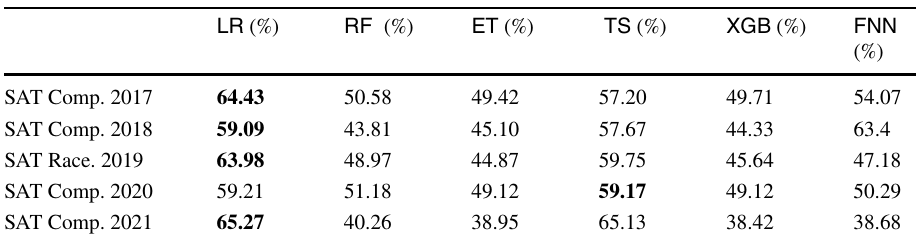
Table 5 Percentage of correctly classified real-world SAT benchmarks of the SAT Competitions from 2017 to 2021 according to their estimated temperature for different regression methods trained The regressor with the best accuracy for each competition is marked in bold. LR stands for linear regres- sion, RF for Random Forest, LR for Extra Trees, TS for Theil–Sen, and XGB for